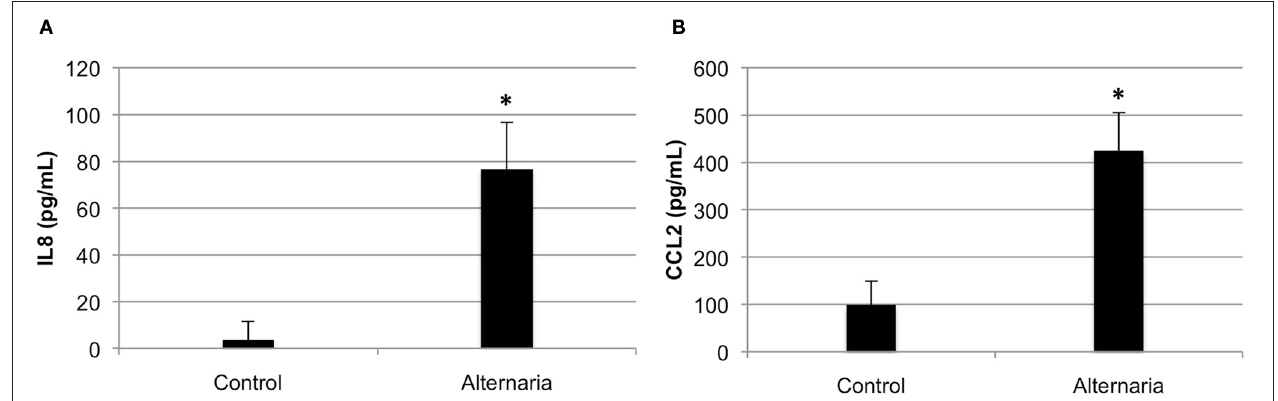
FIGURE 10 | Cytokine secretion by human bronchial epithelial cells in response to Alternaria alternata spores. BEAS-2B human bronchial epithelial cells were challenged with 1 × 10 5 A. alternata wild-type spores and ELISA was used to assay cell-free supernatants for (A) IL8 or (B) CCL2. ∗ p ≤ 0 . 01 vs.